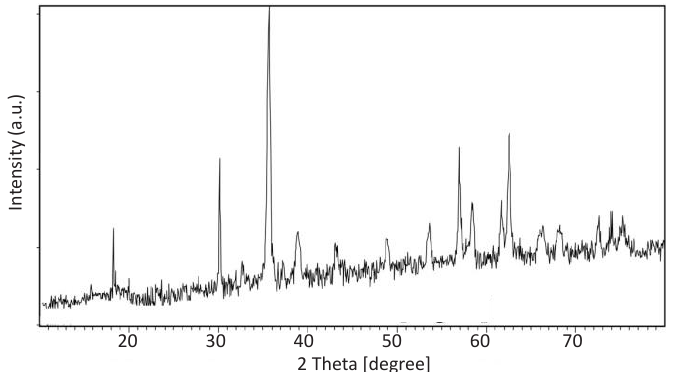
Fig. 1. XRD pattern of CuFe